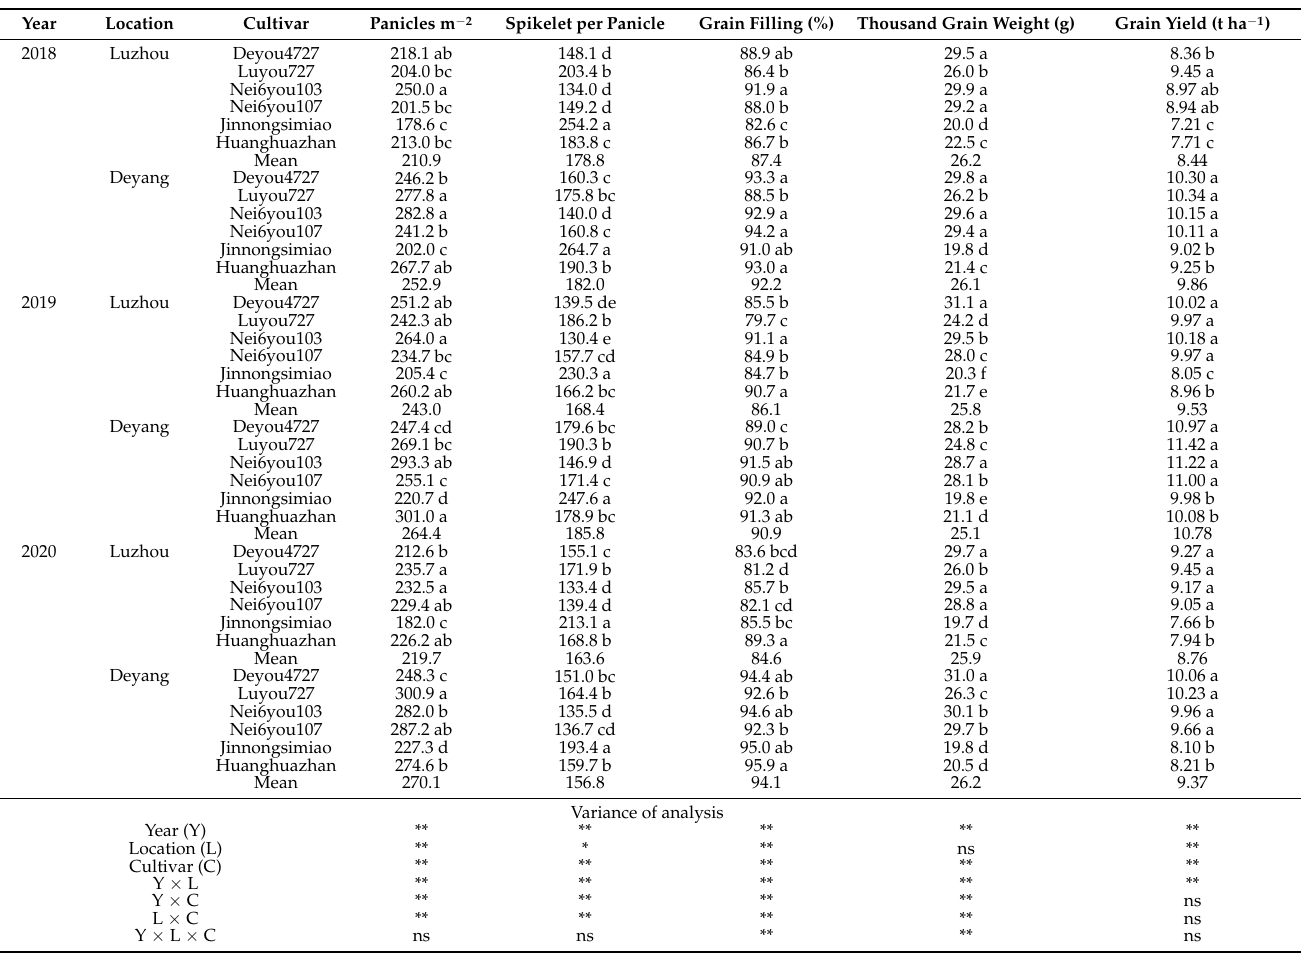
Table 3. Grain yield and yield components of six rice cultivars grown under two different ecological conditions in a field experiment from 2018 to